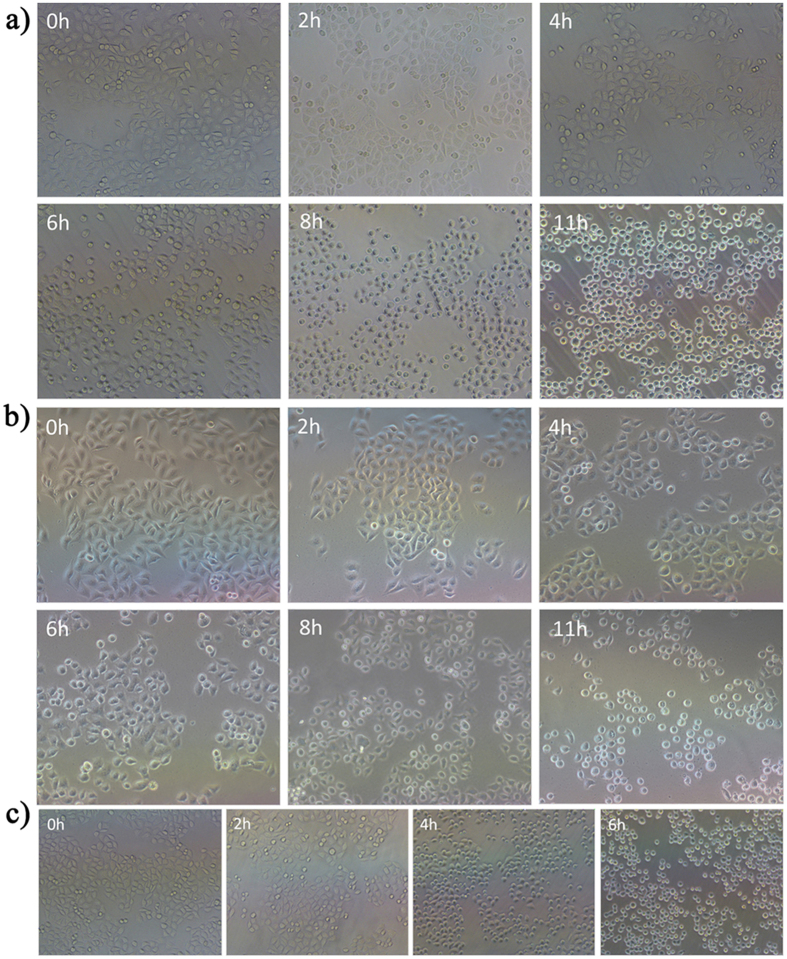
Morphological changes of HeLa cells incubated by (a) 4,
(b) 8 and (c)
K14[As2W19O67(H2O)]
with concentrations of 1 mg/mL.